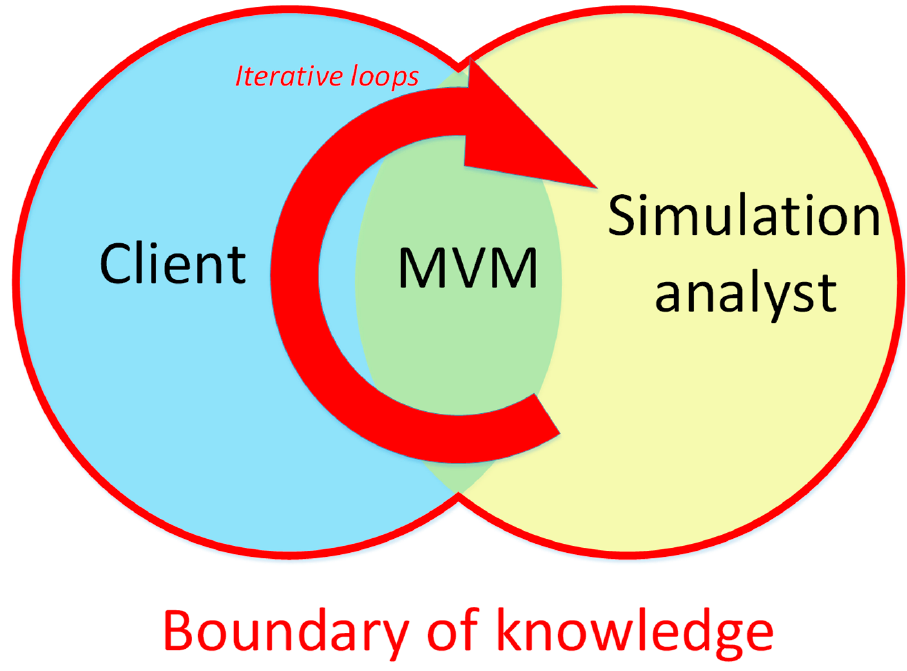
Figure 2. MVM between client and simulation analyst.